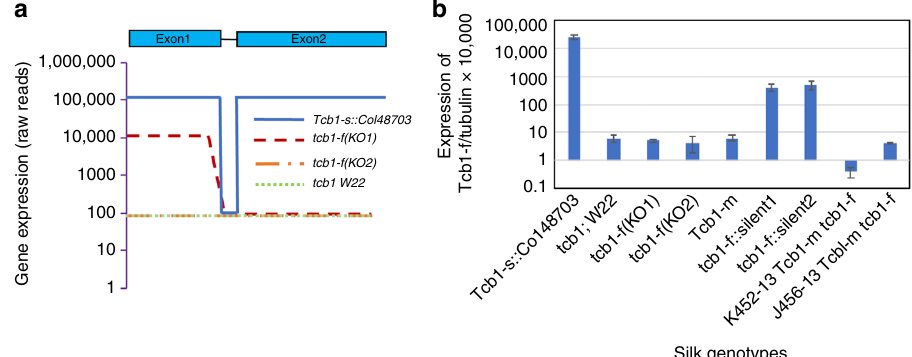
Fig. 2 Gene expression pro fi ling identi fi es a PME38 as a Tcb1-f candidate gene. RNA samples collected from silks of different genotypes was analyzed by RNA-Seq and RT-PCR. a Tcb1-f/PME38 gene structure is shown above the graph (solid line indicates single intron), and RNA-Seq read depth is shown for the Tcb1-f/PME38 gene. b Tcb1-f/PME38 gene expression, compared to tubulin levels as a control, as measured by qRT-PCR in Tcb1- s and loss-of-function Tcb1-s lines: Tcb1-s , full strength Tcb1-s barrier line; tcb1-f(KO1) and tcb1-f(KO2) , two loss-of-function alleles from a Mutator transposon mutagenesis; Tcb1-m , a spontaneous Tcb1-male only line; tcb1-f::silent lineage1 and tcb1-f::silent lineage2 ; and K452-13 and J456-13 , two Tcb1-male only lines that lost Tcb1-f by recombination. Error bars equal the standard error of the mean. Source data for RT-PCR are provided as a Source Data fi le. RNA-seq reads provided in